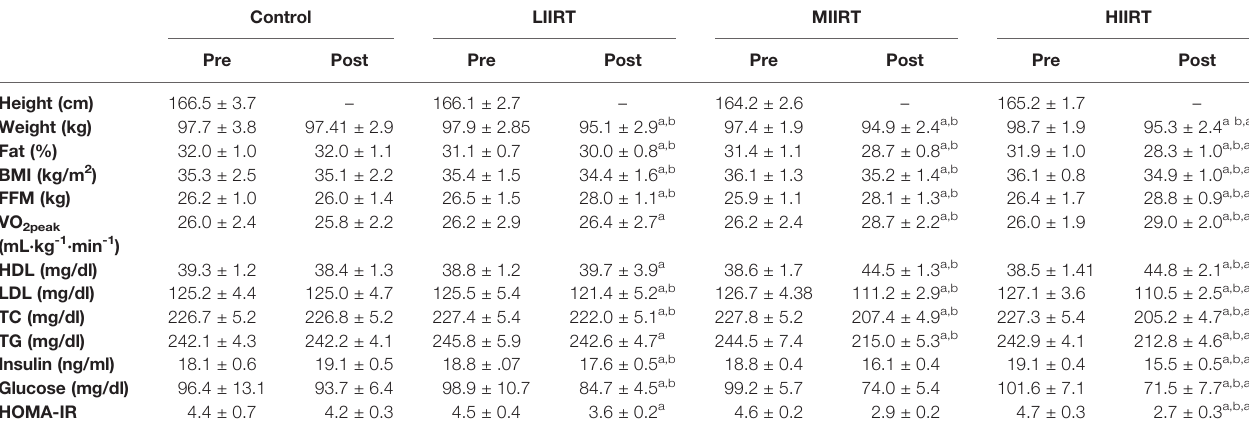
TABLE 3 | Mean ( ± SD) values of glucose, insulin, lipid pro fi le, body composition, and VO 2peak for four groups.